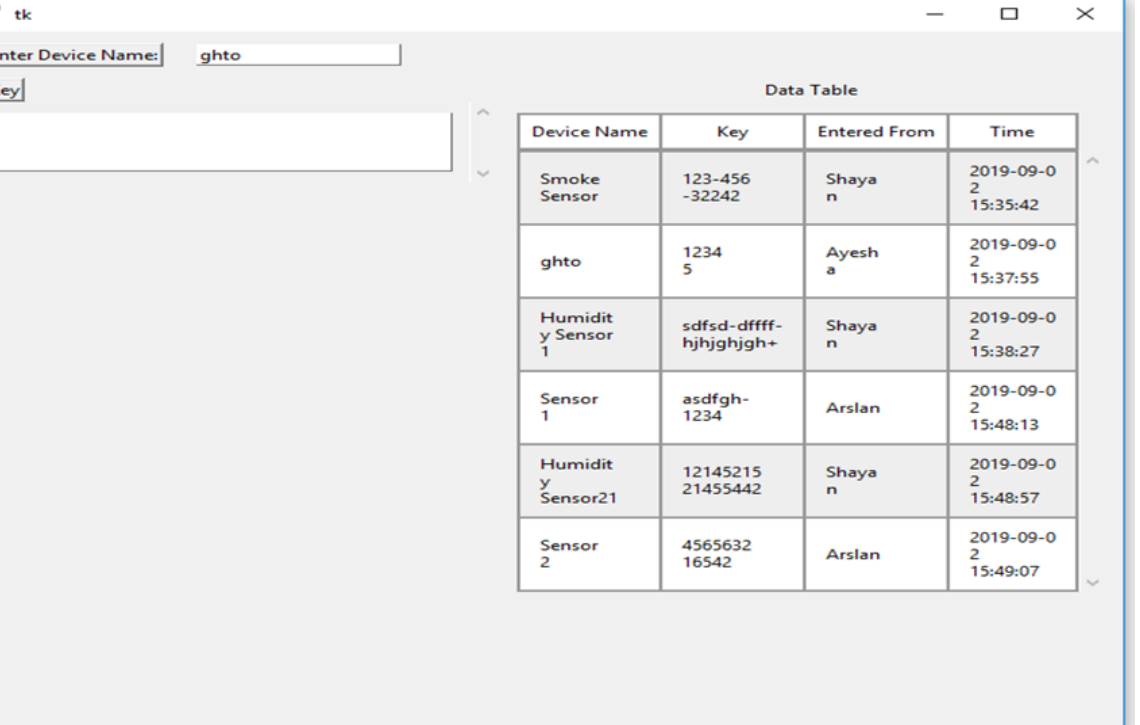
Figure 4. Data of the chain.